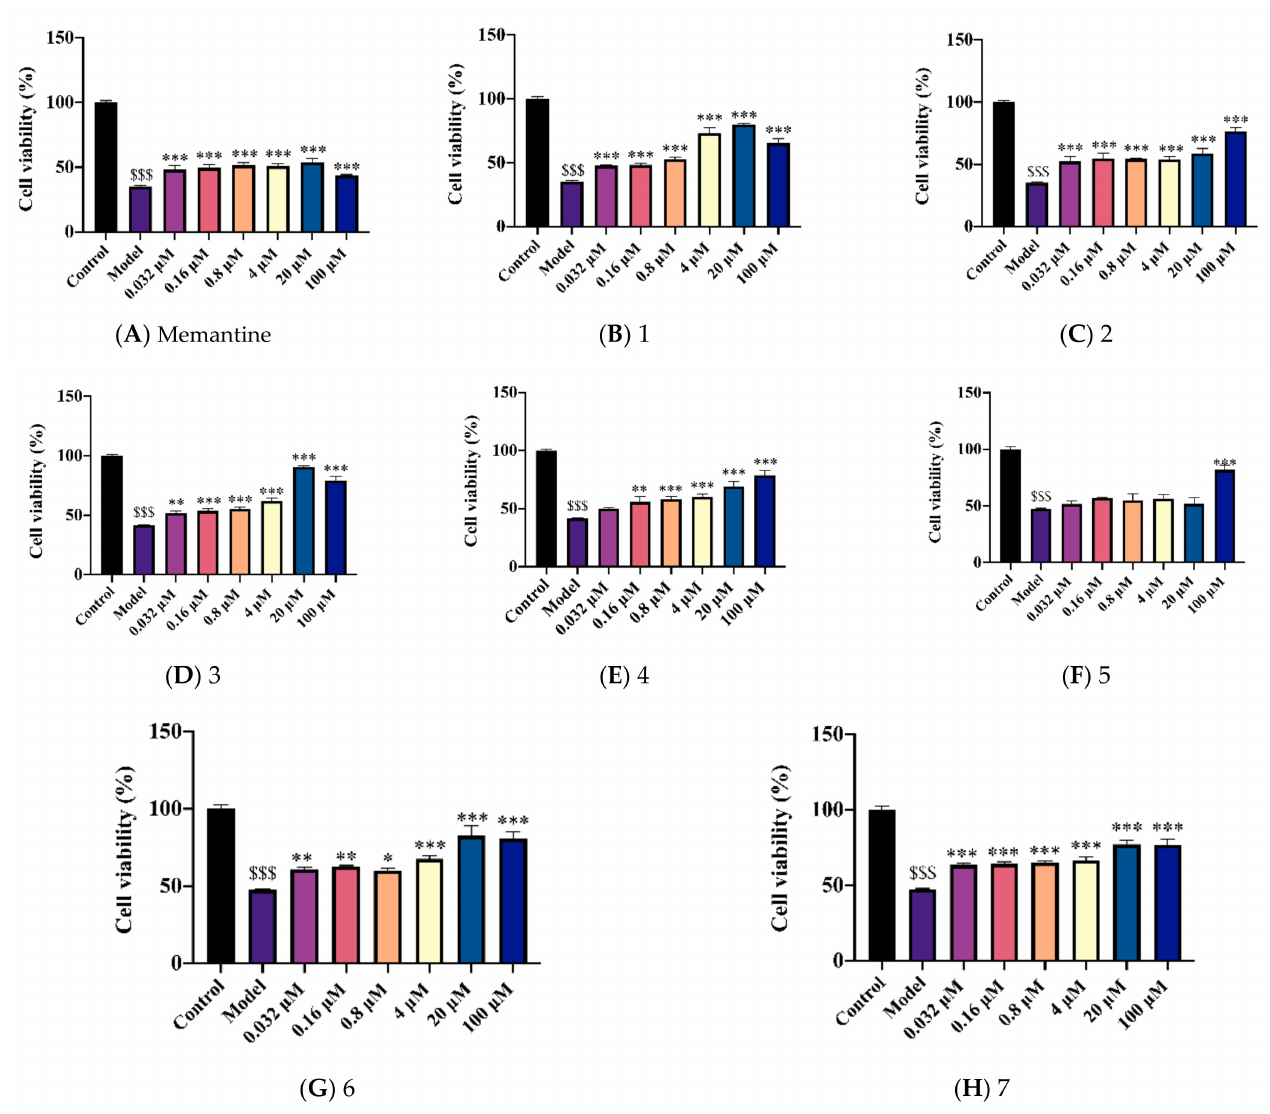
Figure 3. Cell viability of copper-injured APPswe cells treated with novel structural derivatives of memantine. ( A – H ) Cell viability of memantine (as a positive reference drug) ( A ) and memantine derivatives, including 1 ( B ) modafinil-memantine, 2 ( C ) piracetam-memantine, 3 ( D ) picamilon- memantine, 4 ( E ) glycyl-glycine-memantine, 5 ( F ) glycyl-glycyl-glycine-memantine, 6 ( G ) sarcosine- memantine, 7 ( H ) dimethylglycine-memantine, using MTS assay. Data are expressed as mean ± SEM, n = 3. $$$ p < 0.001 vs. the control group; * p < 0.05, ** p < 0.01, *** p < 0.001 vs. the